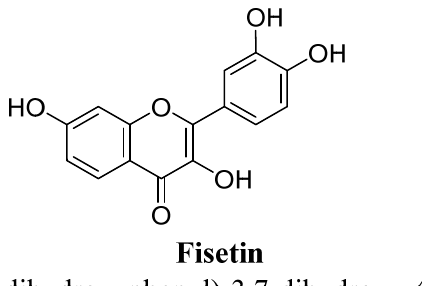
Figure 15. Figure 15. Fisetin.